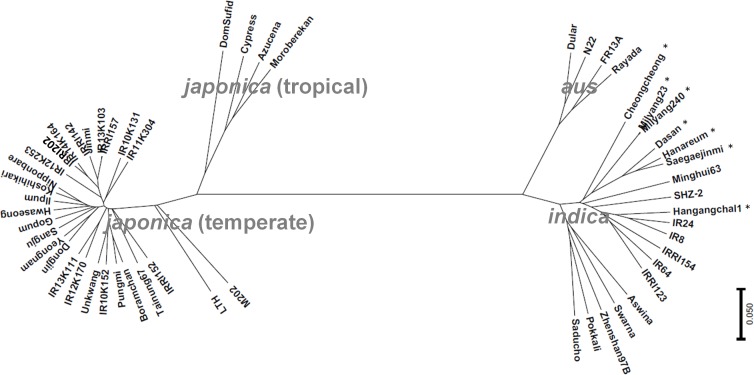
Phylogenetic analysis. All materials, except for three accessions (Kitaake, Taichung 65, and Kasalath), were analyzed by 6K SNP chip and the phylogenetic tree was constructed by using 2,918 SNP data points. The samples were grouped into aus, indica, tropical japonica, and temperate japonica types consistent with the previous report (McNally et al., 2009). Asterisk (∗) refers to Tongil-type rice cultivars.